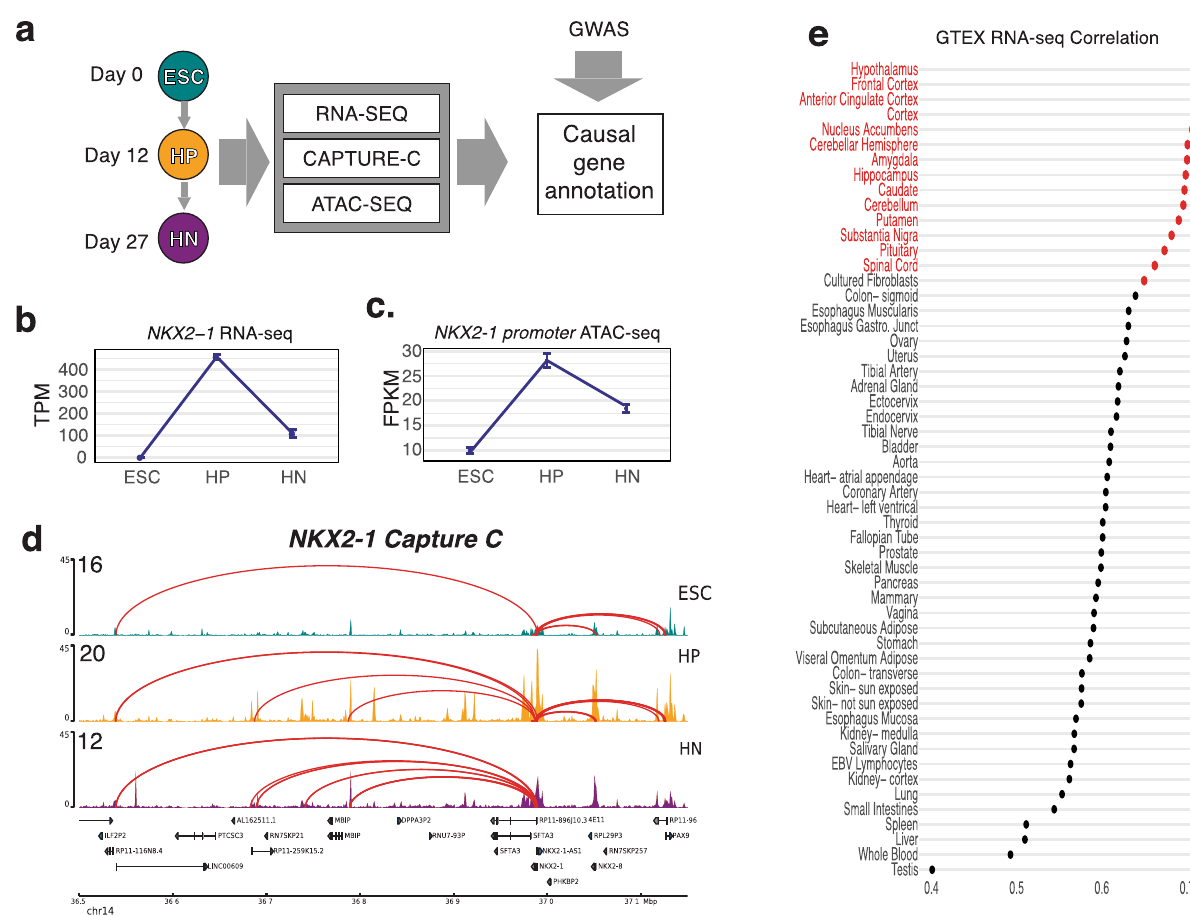
Fig. 1 An integrative functional genomics approach to model the differentiation of hypothalamic neurons. a Schematic of the study design. ESC, HP, and HNs were used to generate RNA-seq, ATAC-seq, and Capture C pro fi les, which we compared to the GWAS signals mined using our variant-to-gene mapping approach. b Expression level of NKX2-1 determined by RNA-seq (error bars re fl ect standard deviation; n = 3). c Accessibility change of OCR located in the NKX2-1 promoter over the course of HN differentiation (error bars re fl ect standard deviation; ESC, HP n = 4; HN n = 6). d A 600 kb region around the NKX2-1 gene in ESCs (teal), HPs (purple), and HNs (orange). The peaks track represents the ATAC-seq coverage, where higher peaks depict increased accessibility (open chromatin), and arcs represent signi fi cant (Chicago Score >5) interacting regions between the NKX2-1 promoter. e Comparison of HN expression pro fi le to median GTeX database, scores give the Spearman correlation coef fi cient of the top 16,953 genes expressed in both